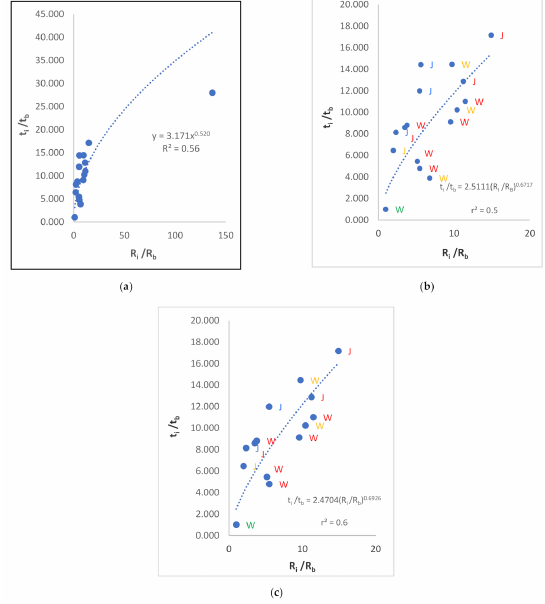
Figure 10. The ( a ) 17 preforms, ( b ) 16 preforms, and ( c ) 14 preforms.